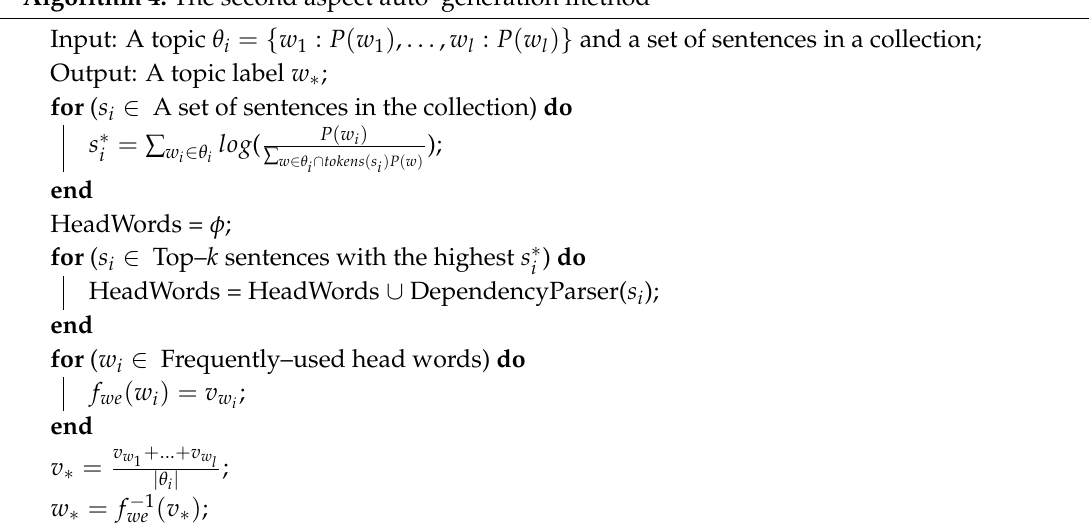
Algorithm 4: The second aspect auto–generation method